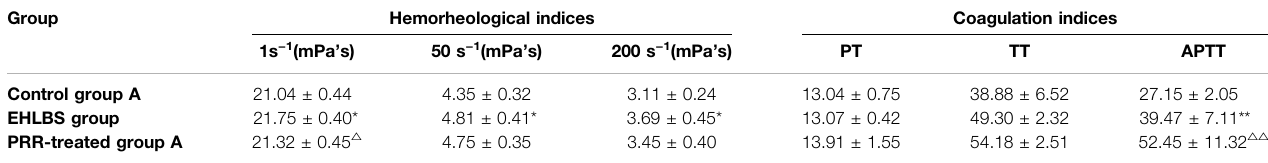
TABLE 2 | Comparison of hemorheological indices and coagulation indices among different groups of the rats in EHLBS stage ( ‾ x ± s, n = 10). Group